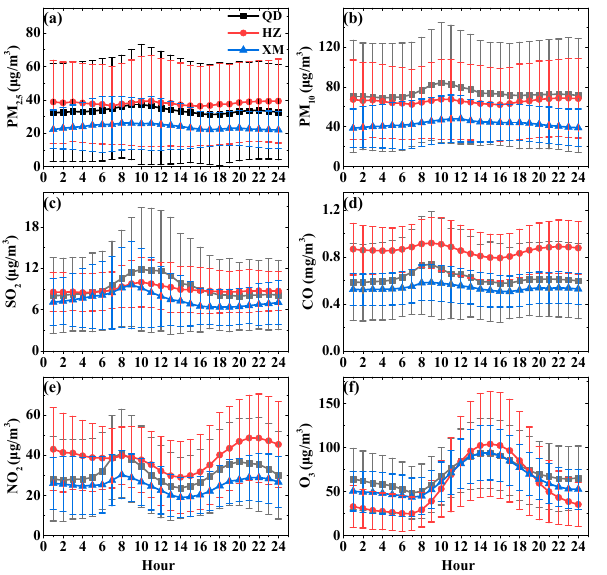
Figure 8. Diurnal variations and corresponding standard deviation of PM 2.5 ( a ), PM 10 ( b ), SO 2 ( c ), CO ( d ), NO 2 ( e ), and O 3 -1h ( f ) in Qingdao (QD), Hangzhou (HZ), and Xiamen (XM) during 2018.